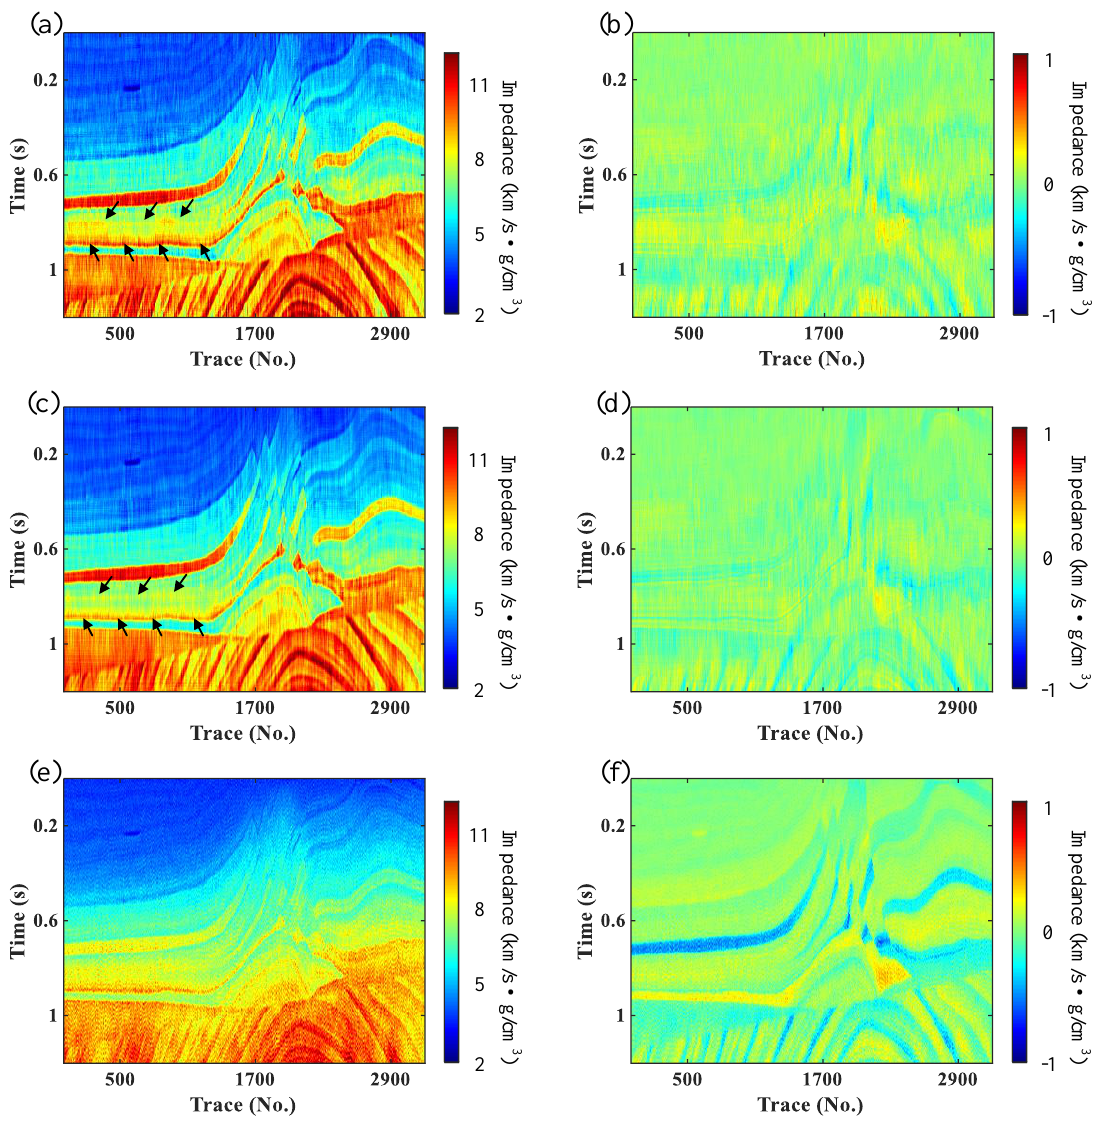
Figure 6. ( a ) The inverted impedance using SSII without f-x filtering. ( b ) The residual profiles between SSII inversion results without f-x filtering and reference values. ( c ) The inverted impedance using MSII without f-x filtering. ( d ) The residual profiles between MSII inversion results without f-x filtering and reference values. ( e ) The inverted impedance using MDII without f-x filtering. ( f ) The residual profiles between MDII inversion results without f-x filtering and reference values.